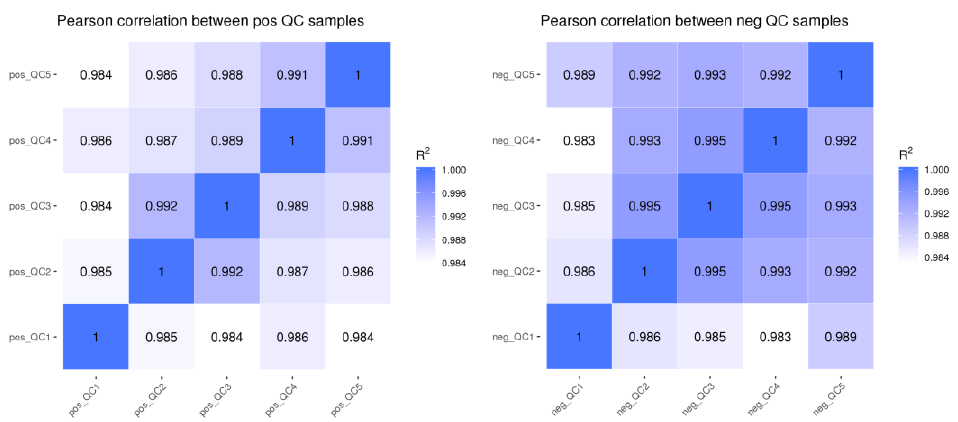
Figure 1. Correlation analysis of QC samples. Note: QC 1-5 represents five replicates of QC samples. POS: positive ion mode; NEG: negative ion mode.